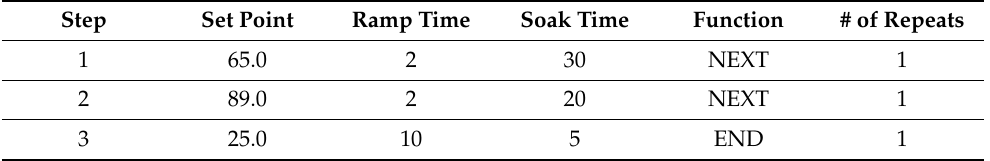
Table 4. The ‘set point’, ‘ramp time’, ‘soak time’, ‘function’, and ‘# of repeats’ inputs for soft-baking in Teca